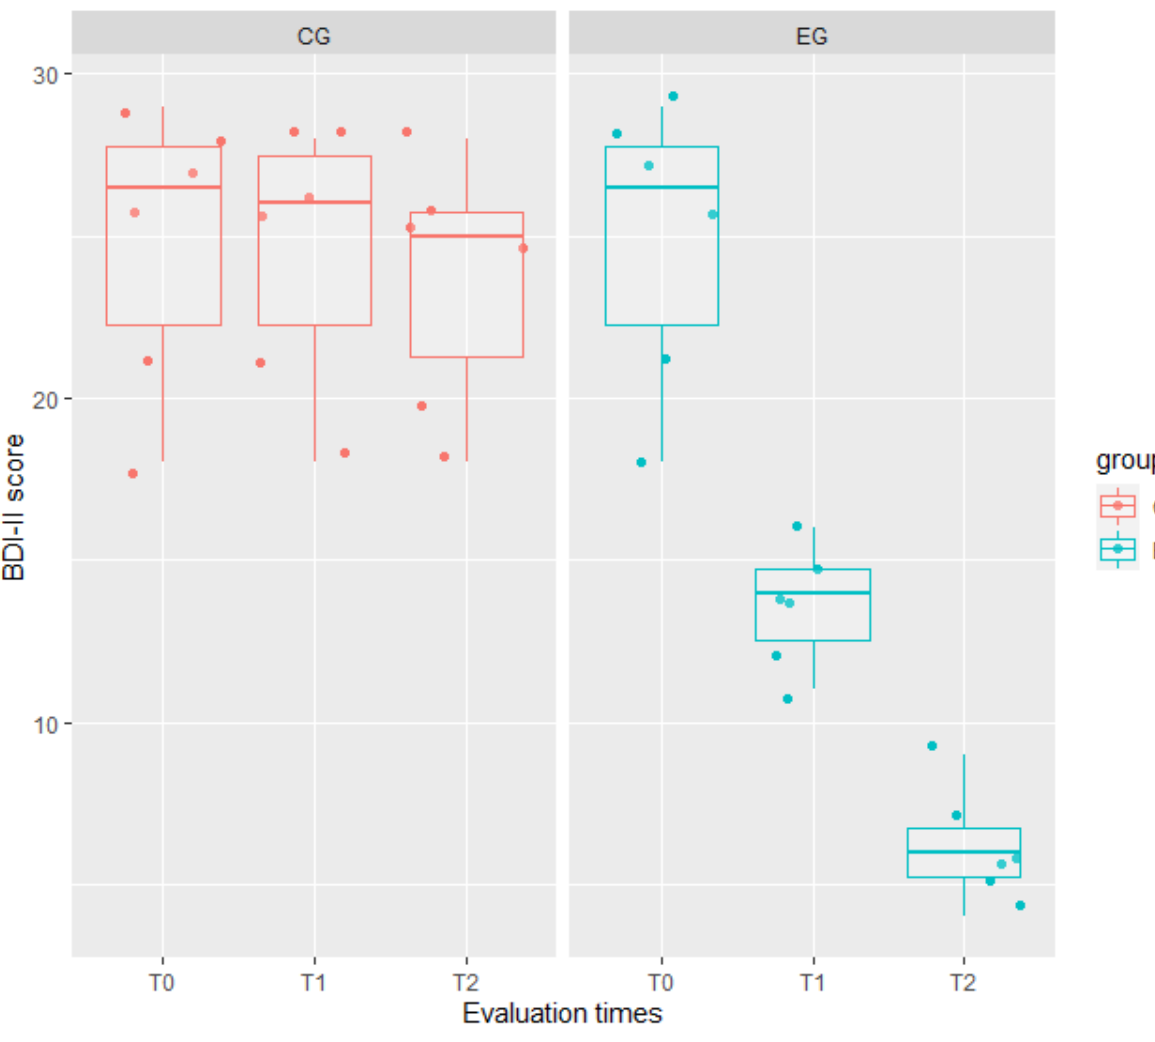
Figure 3. Comparison of depression scores (measured by BDI-II = Beck Depression Inventory) between the experimental group (EG) in green, and the control group (CG) in red, at any evaluation time (T0, T1, and T2). Any box represents data distribution: the bounds at the top and bottom are the first and third quartiles, the center line is the median value, the whiskers from the box indicate the minimum and maximum values, dark (jittered) points represent patient BDI-II scores, while clear points represent outliers. CG boxplots show a not significant decrease among evaluation times, while EG boxplots show a significant decrease from T0 to T2.